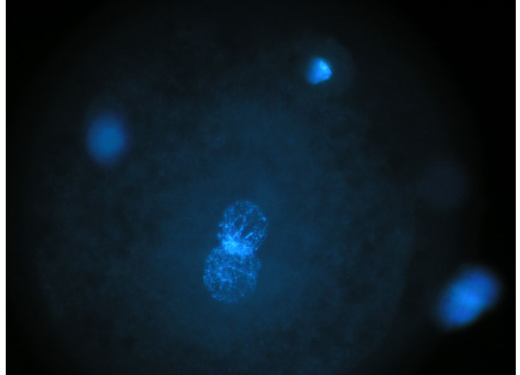
Figure 3. Pronuclear stage evaluated 16 hours after injection with freeze-dried sperm and stained with Hoechst 33342: two polar bodies and two pronucleus.